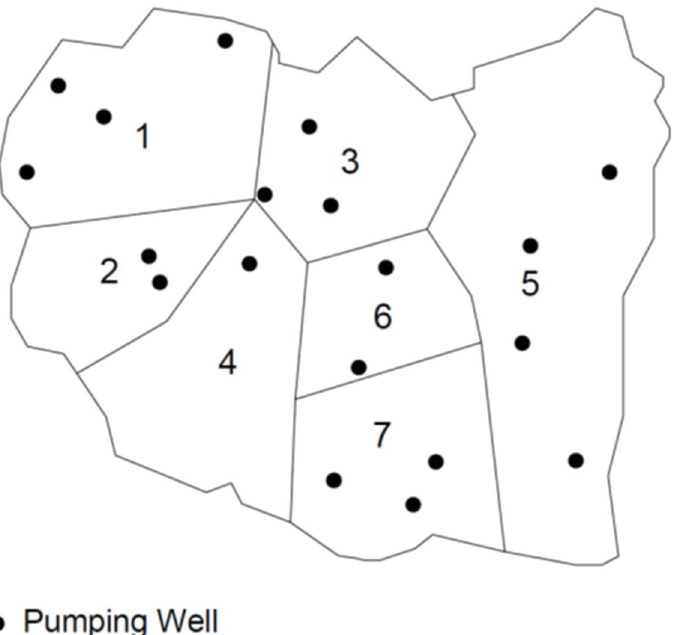
Fig 11. Large-scale test case hydrologic zones and pumping wells.